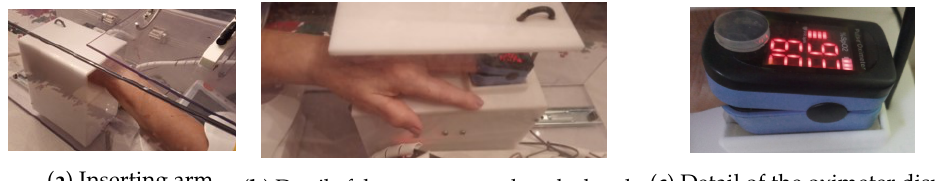
Figure 2. Details of the experiments with the IPMA. In ( a ), an individual inserting his/her arm; in ( b ), the detail of the structure where the hand is placed to measure body temperature and oxygen saturation; in ( c ), a photo of the oximeter display. The upper number (right in the image) is the oxygen saturation, and the bottom number (left in the image) is the heart rate. There is a silicone cover on the power button to avoid the linear actuator damaging the oximeter.